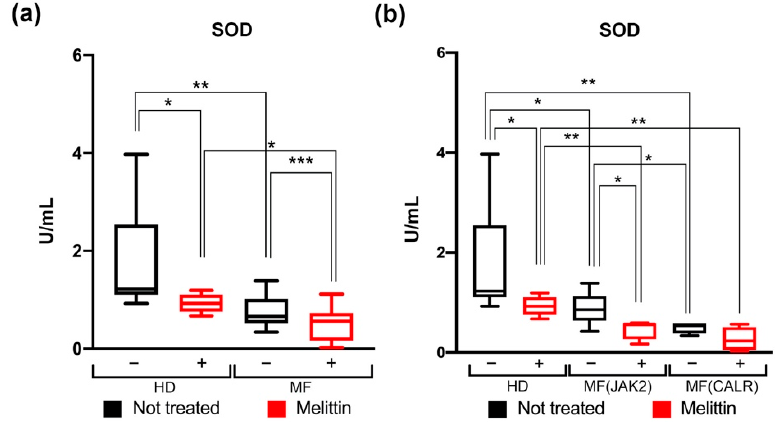
Figure 2. Measurement of SOD activity in CD34+ cells of MF patients. ( a ) Box plot shows the SOD activity in HD and in MF Scheme 24. hours Melittin treatment respectively. ( b ) Box plot shows the percentages of SOD activity in the comparison between JAK2 or CALR -mutated MF patients compared to HD, with (red bars) or without (black bars) 24 h Melittin treatment respectively. SOD activity was normalized based on total amount protein were used to perform the assay. Data are reported as median of SOD activity (expressed in U/mL) with 95% CI (confidence interval). The comparisons between HD and MF were performed using Mann–Whitney U test, while the comparisons between treated and not treated cells were analyzed using Wilcoxon matched-pairs signed rank test. * p < 0.05, ** p < 0.01, *** p < 0.001.